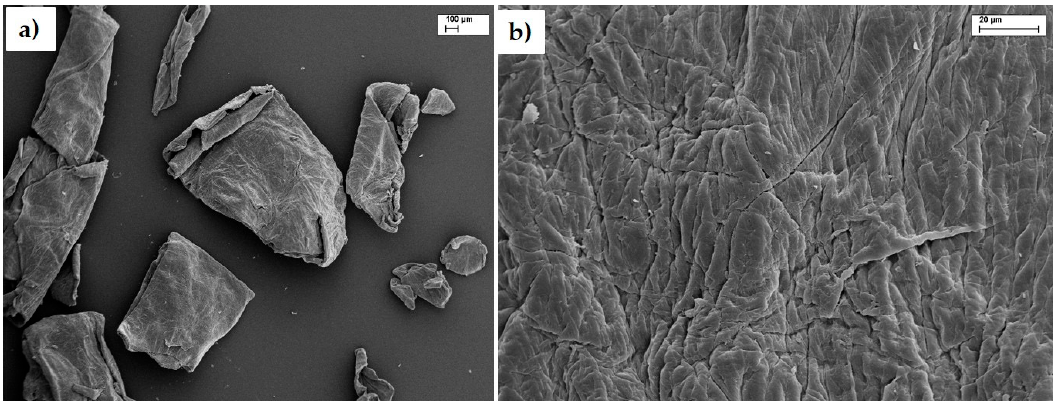
Figure 5. Scanning electron microphotographs of chitosan flakes: ( a ) 61×, ( b ) 1500×.